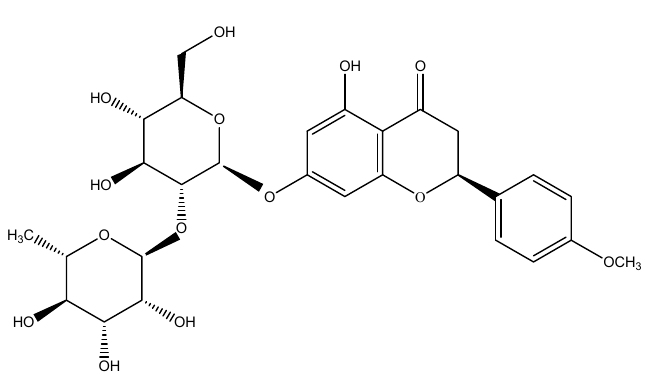
Figure 1. Molecular structure of